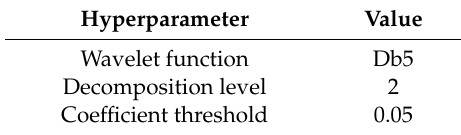
Table 6. Hyperparameters of the spatiotemporal synchrophasor data compression